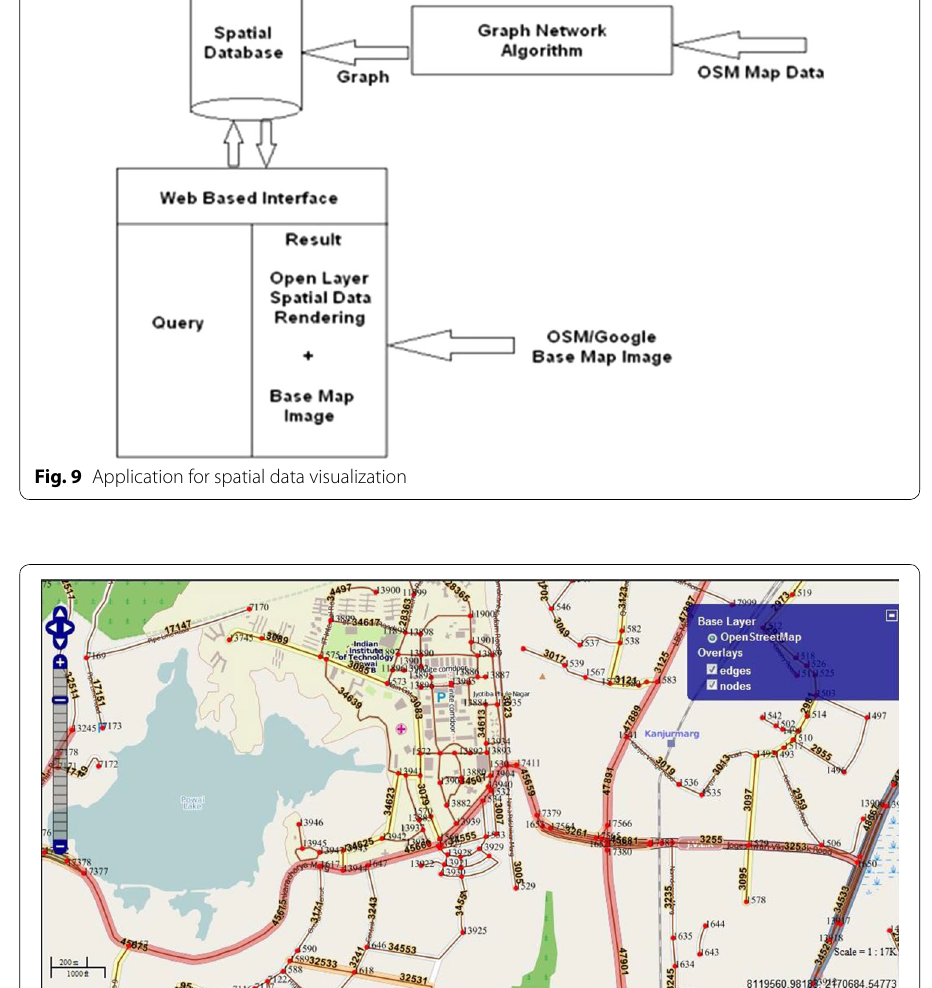
Fig. 10 Road network plotted over Open Street